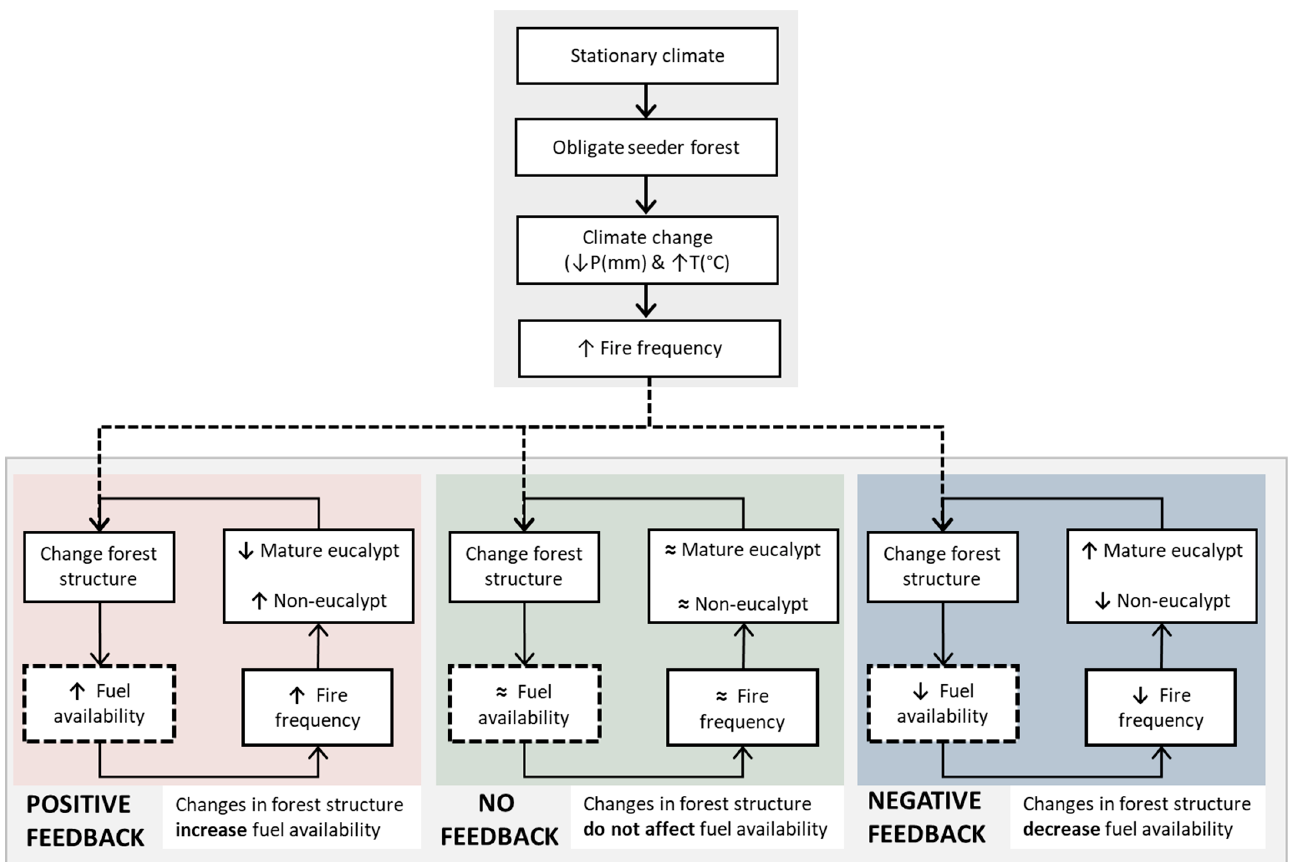
Figure 1. A conceptual model of potential feedback processes in response to climate-change-induced increases to fire frequency in obligate seeding wet forests. Three alternative feedback processes are depicted: positive (pink), no feedback (green) and negative (blue). Dashed lines represent the components of this conceptual model under investigation in this study.